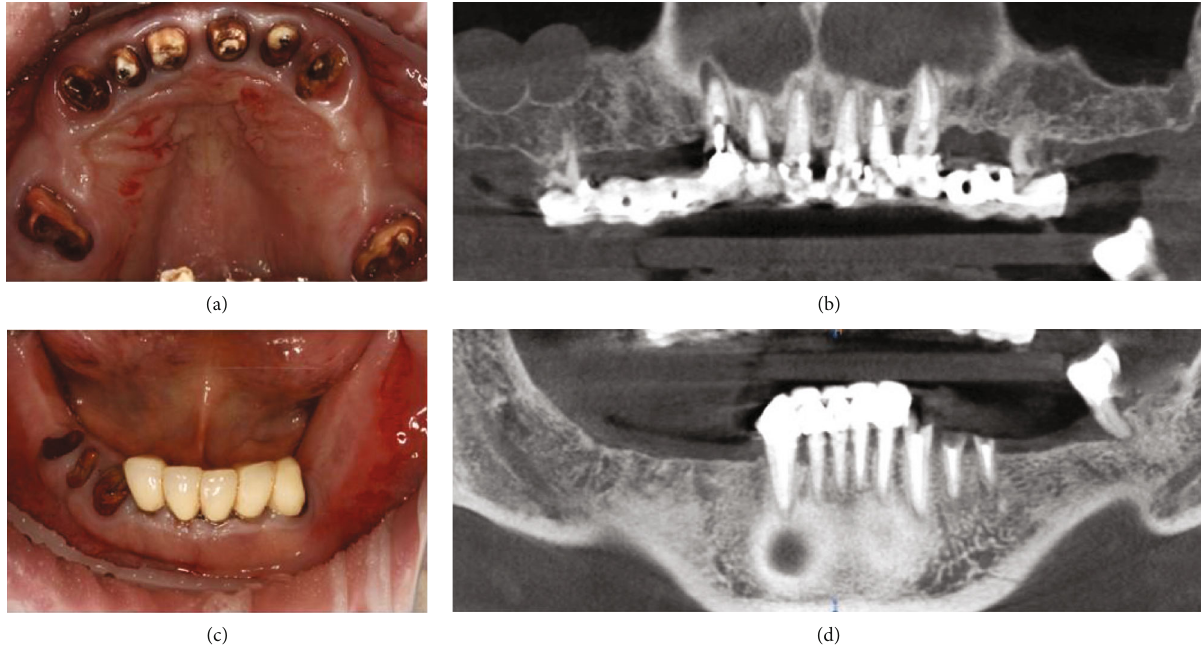
Figure 1: Maxillary (a, b) and mandibular (c, d) teeth condition: multiple carious lesions, absence of ferrule-e ff ect, and periodontal and other changes, which demands for extraction of all decayed